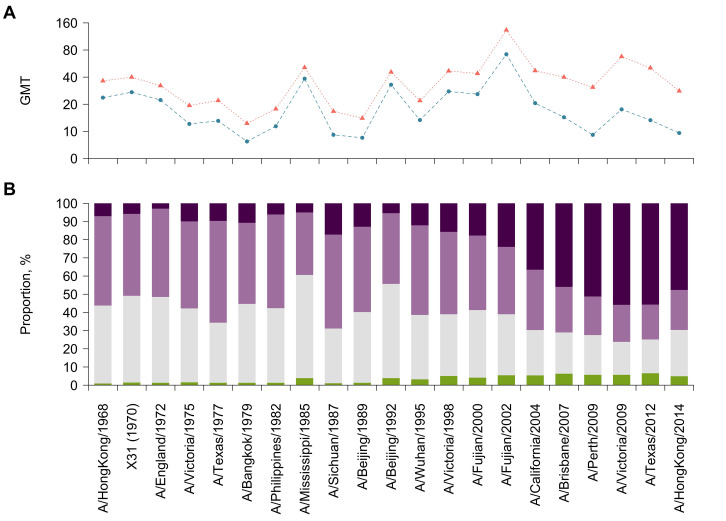
Changes in antibody profiles between visits.(A) Geometric mean titers (GMT) by strain. Blue and red points represent GMT at baseline and follow-up, respectively. (B) Distribution of changes in titers by strain. We divided the changes in titers into four categories, i.e. decrease (green), no change (grey), two-fold increase (light purple) and four-fold change (seroconversion, dark purple).